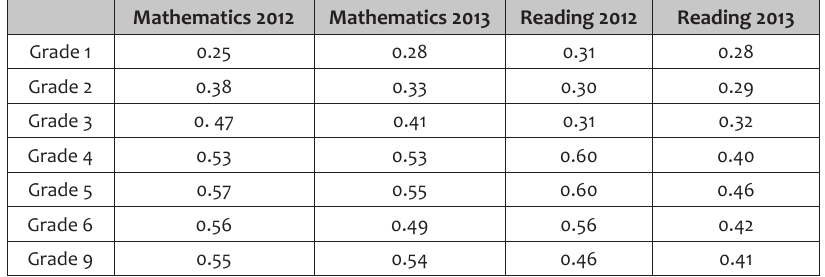
Table 5: Intra-class correlation coefficients (rho values) for 2012 ANA scores